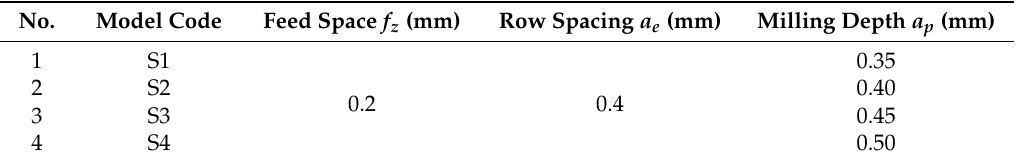
Table 5. Milling parameters of quadrilateral models with different milling depth.